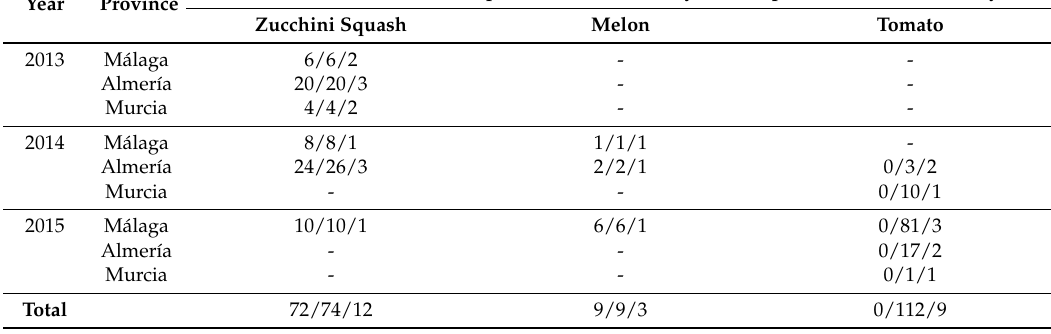
Table 1. Prevalence of tomato leaf curl New Delhi virus (ToLCNDV) in plants collected from commercial fields of zucchini squash, melon and tomato of Málaga, Almería and Murcia provinces (southern and southeastern Spain) during a survey conducted from